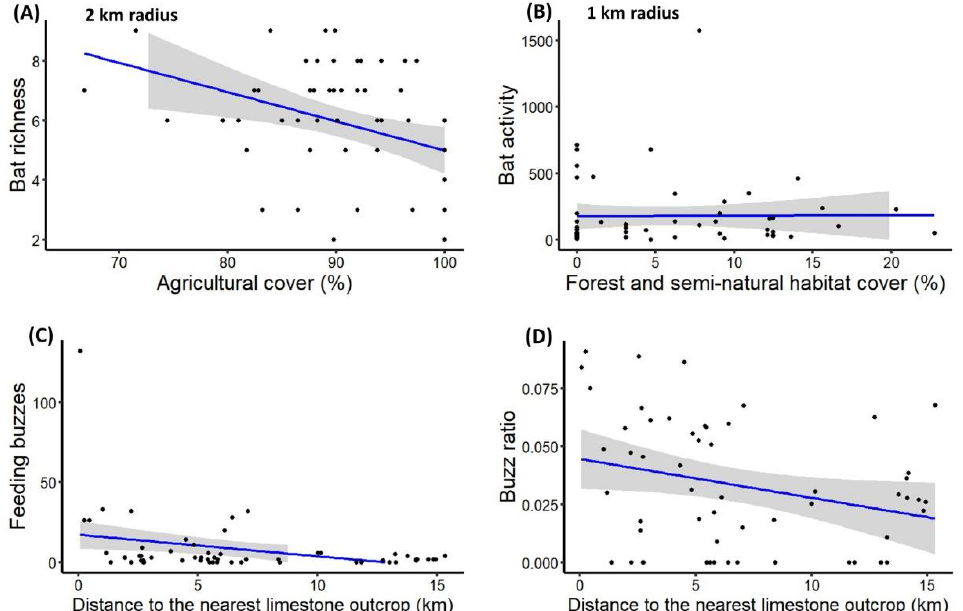
Figure 4. Effects of significant landscape factors on bat species richness, total bat activity and total number of feeding buzzes. ( A ) Percentage of agricultural cover within a 2 km radius had a significant negative effect on bat richness, ( B ) proportion of forest and seminatural habitat cover within a 1 km radius had a significant positive effect on bat activity, and distance to the nearest limestone outcrop had a significant negative effect on the number of feeding buzzes ( C ) and buzz ratio ( D ). All regressions are plotted with 95% confidence intervals .